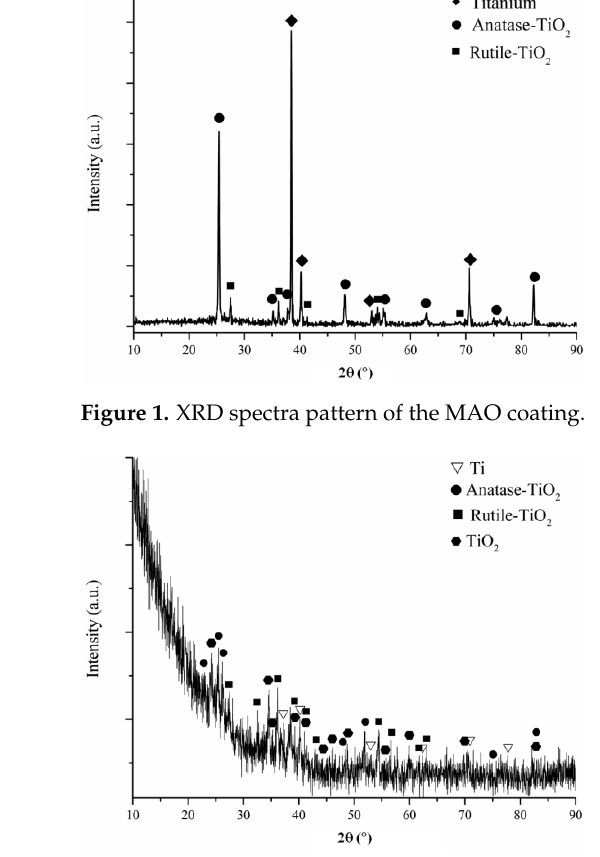
Figure 2. TF-XRD spectra pattern of the Cu-based MAO coating.